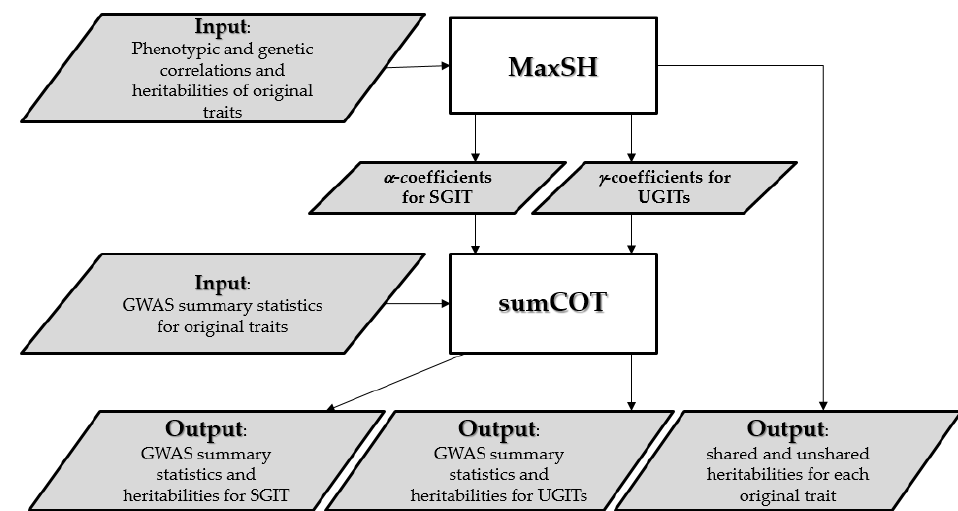
Figure 1. Flowchart of the SHAHER framework. Details are given in the text.